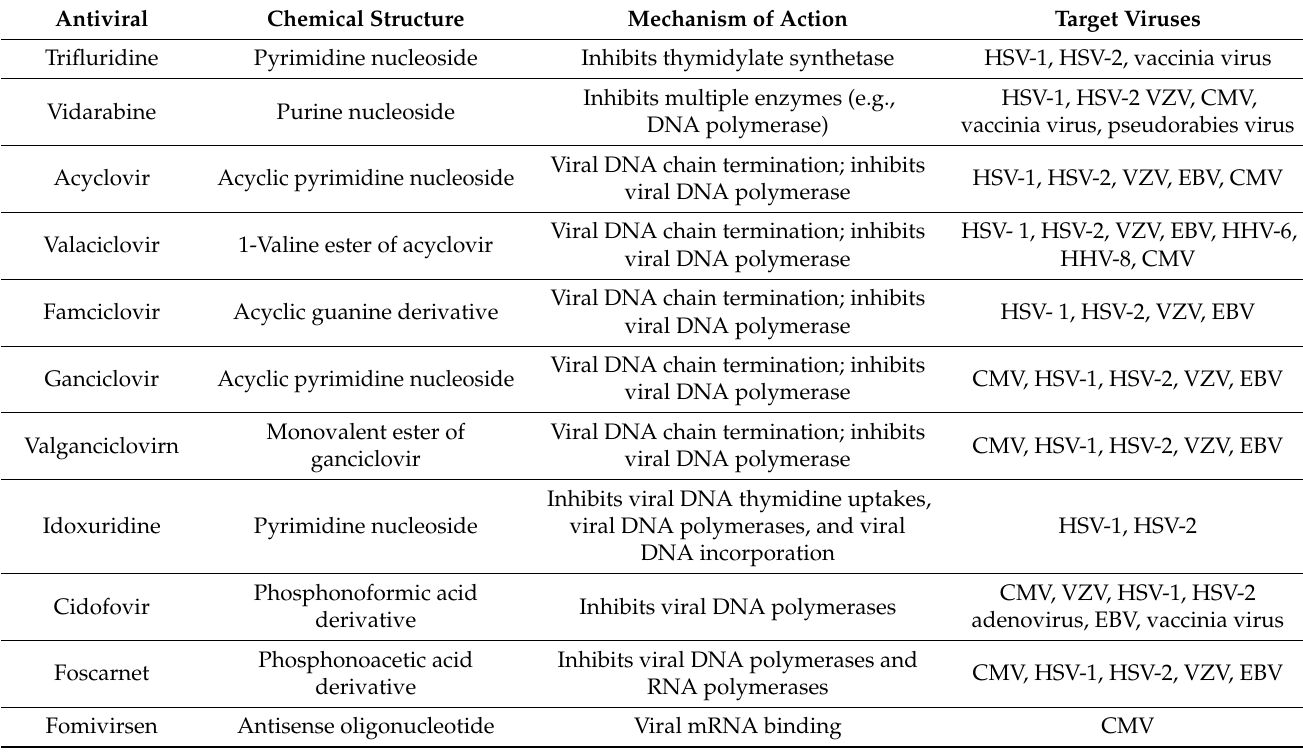
Table 2. FDA-approved antiviral agents for viral ophthalmic